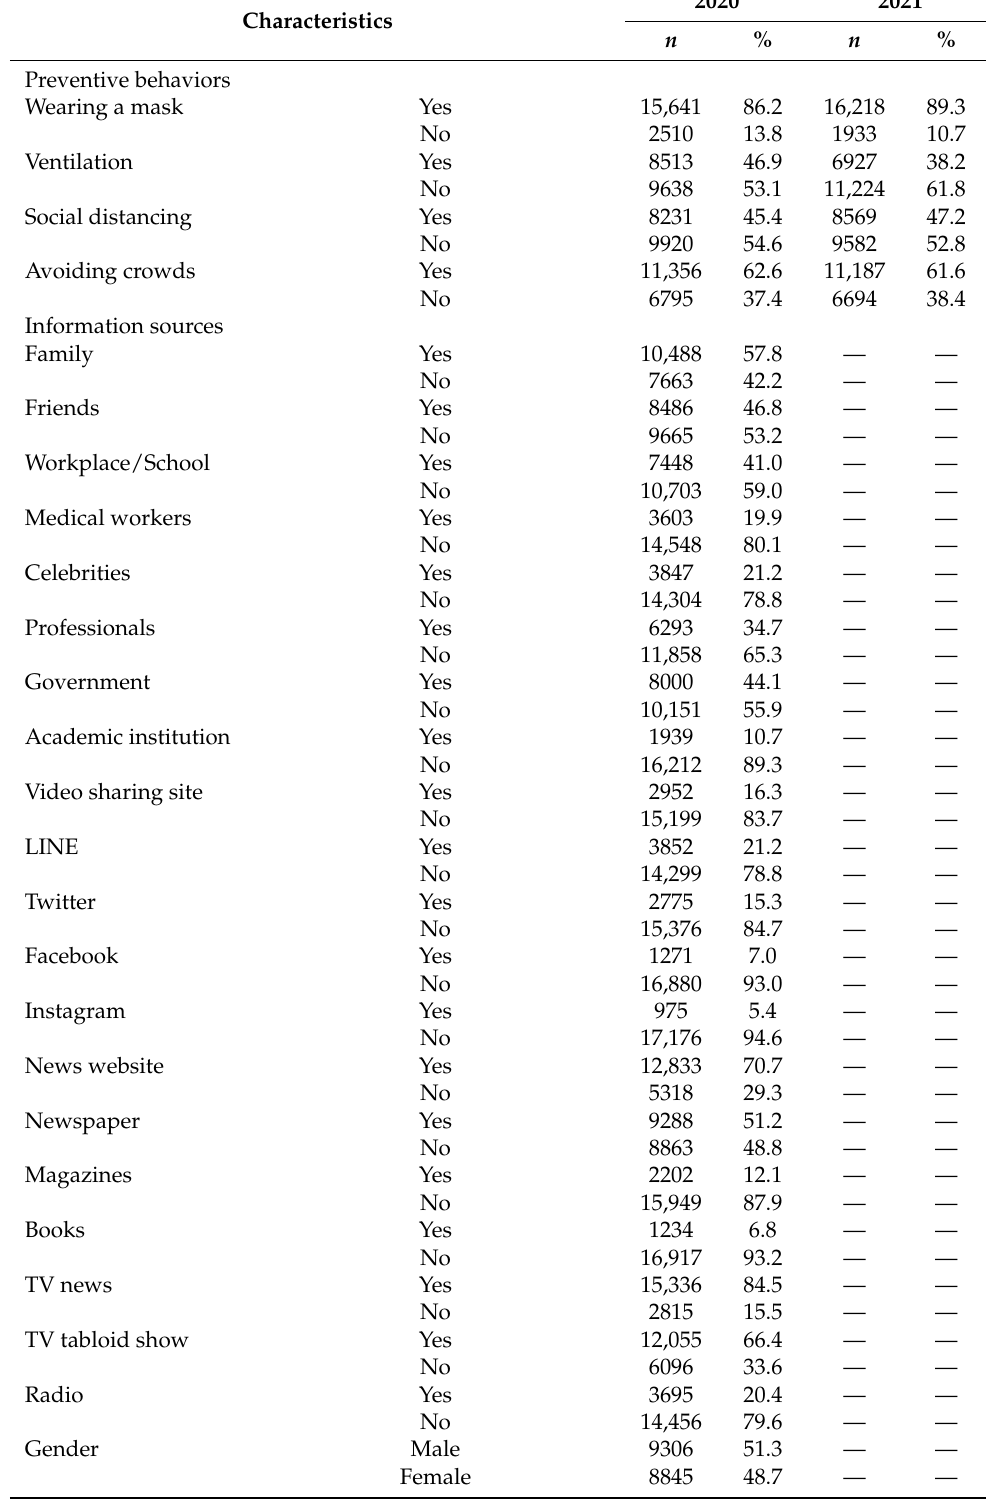
Table 1. The characteristics of the participants ( n = 18,151).